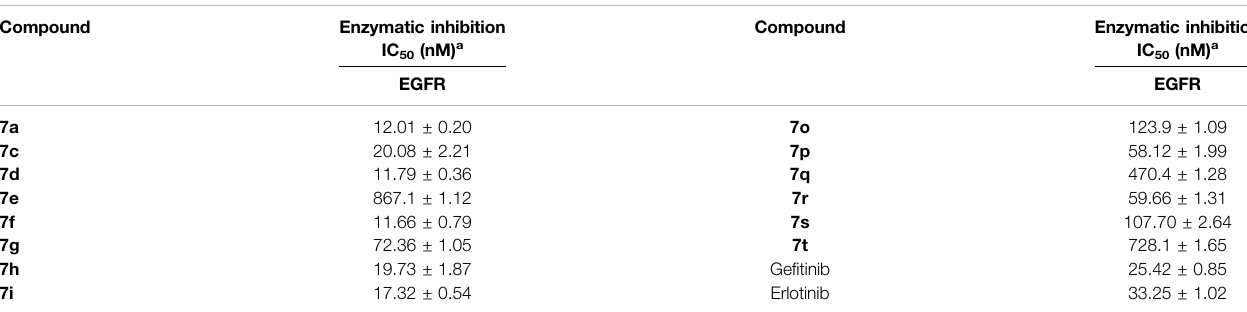
TABLE 2 | Enzymatic results for part of the Compound 7 series